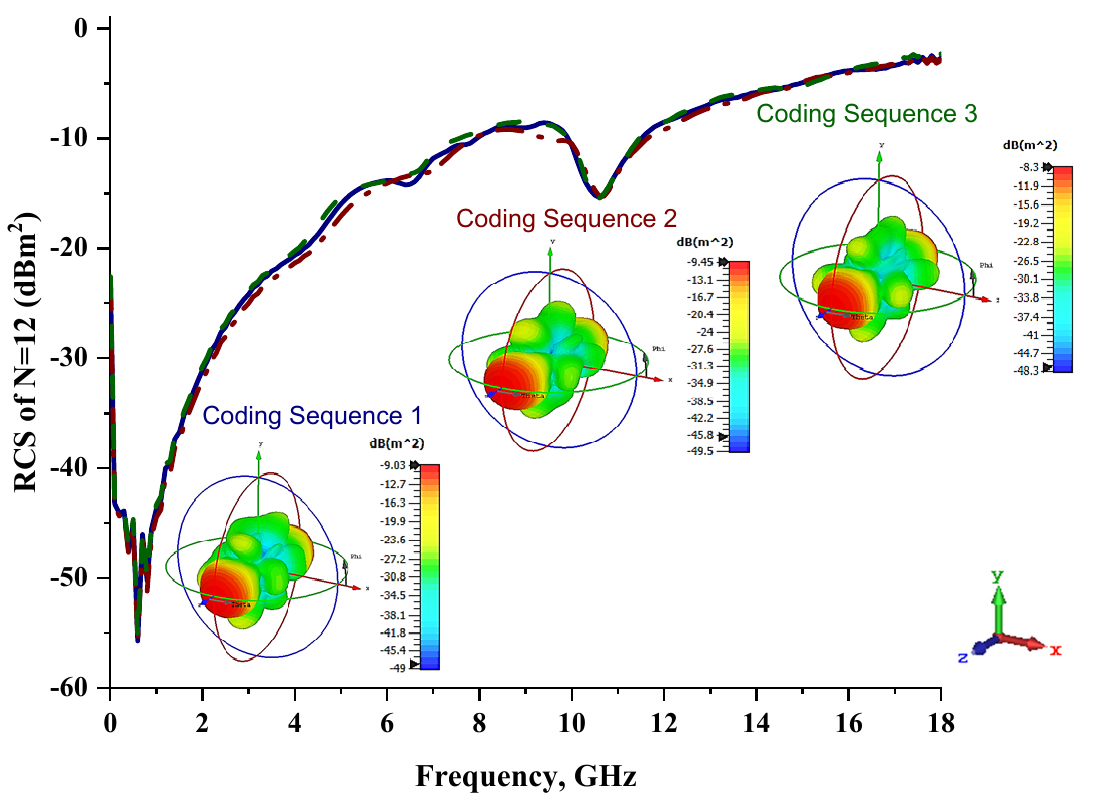
Figure 9. Monostatic RCS and bistatic scattering patterns (at 8 GHz) of three different coding metamaterials with 12 lattices. Table 9. Coding sequences of n = 12 for each row.